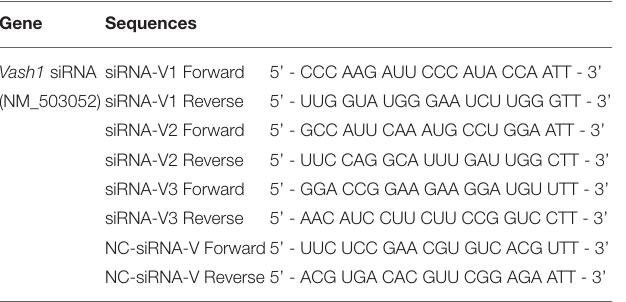
TABLE 1 | Vash1 siRNA gene